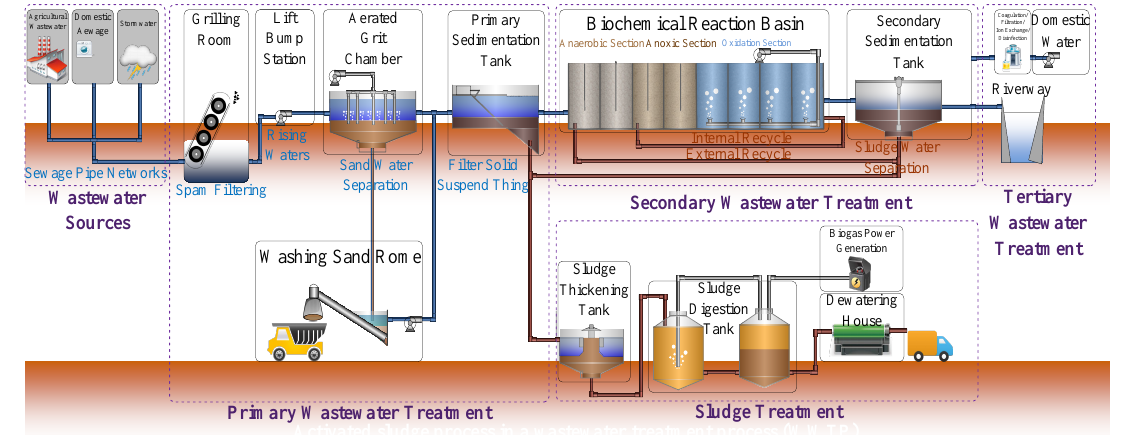
Figure 1. Activated sludge process in a wastewater treatment plant (WWTP).